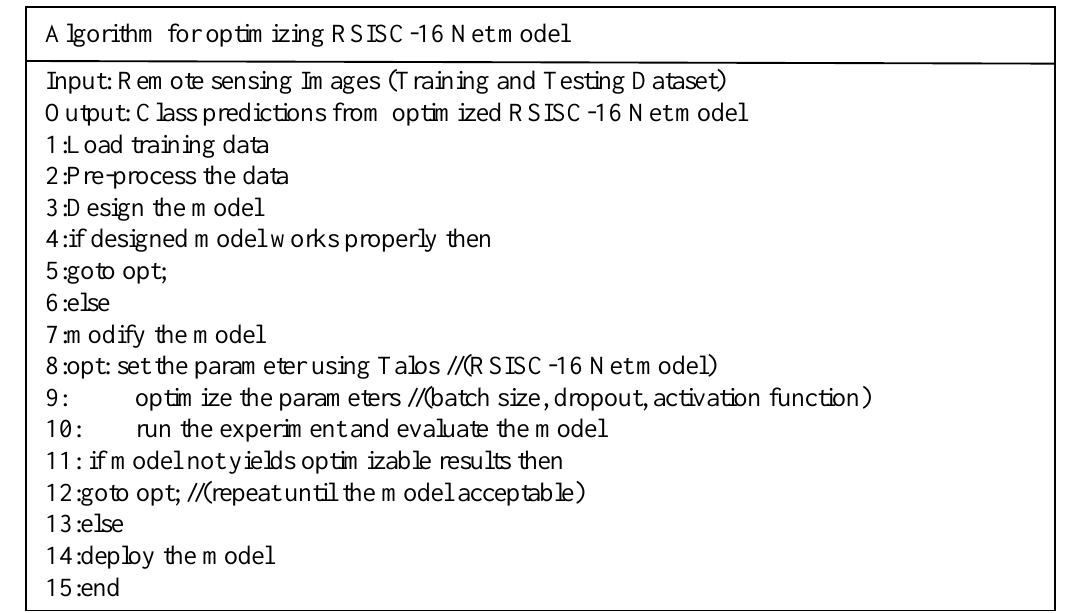
Table 2. Summary of the optimized RSISC-16 Net Model